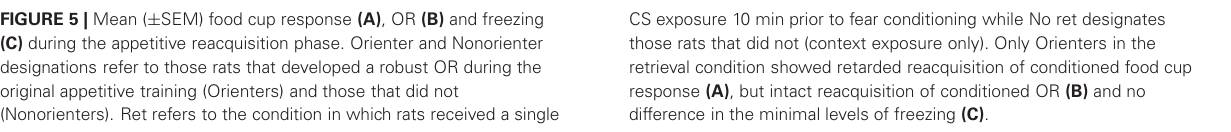
CS exposure 10 min prior to fear conditioning while No ret designates those rats that did not (context exposure only). Only Orienters in the retrieval condition showed retarded reacquisition of conditioned food cup response (A) , but intact reacquisition of conditioned OR (B) and no difference in the minimal levels of freezing (C)